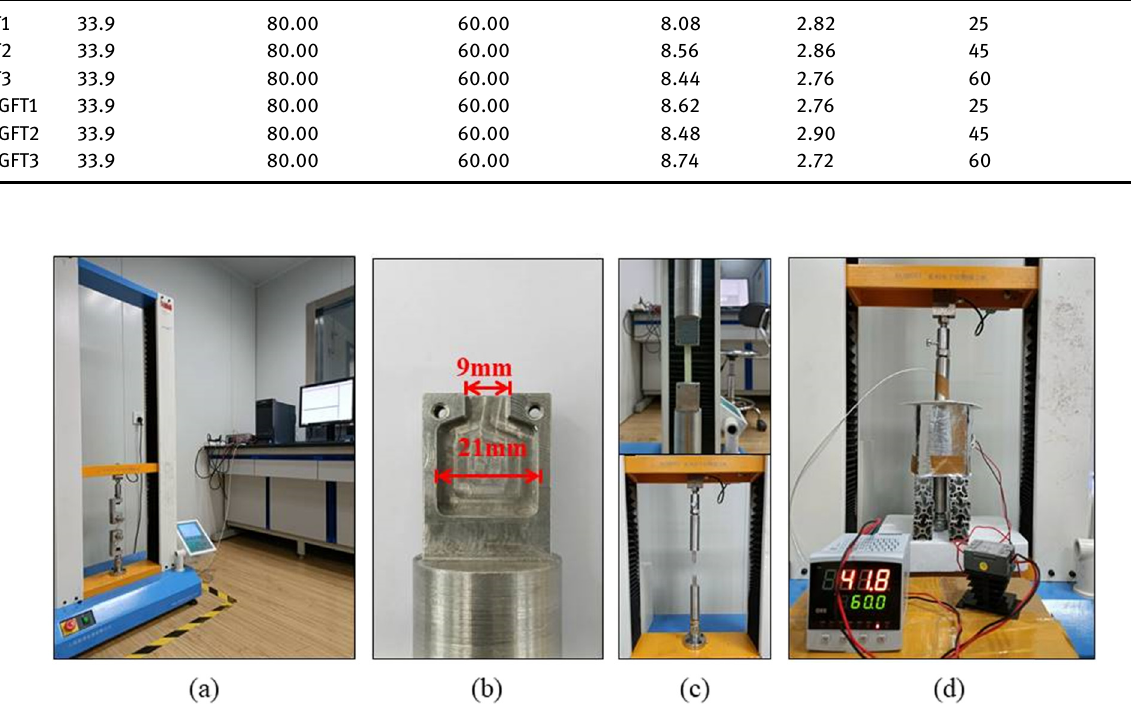
Figure 5: Tensile test procedure: ( a ) electronic fabric strength machine, ( b ) tensile fi xture, ( c ) tensile test at room temperature, and ( d ) tensile test at di ff erent